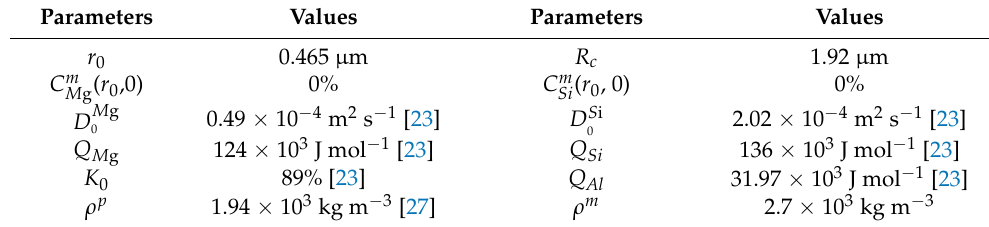
Table 2. Parameter values used in the simulation. Parameters Values